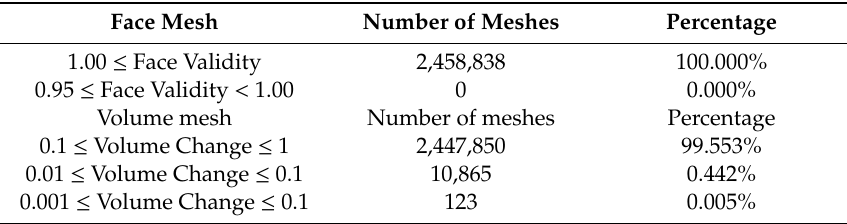
Table 3. Quality of the numerical